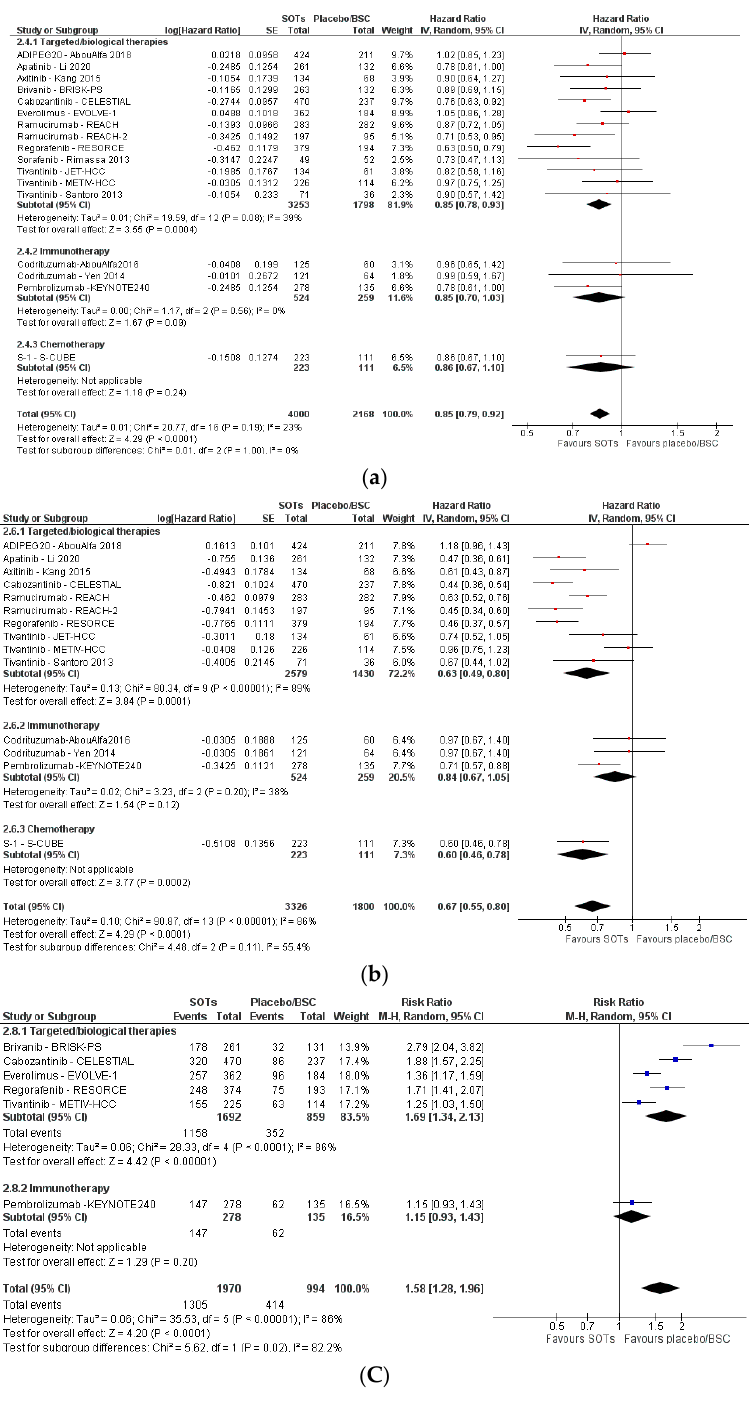
Figure 5. Forest plots for the outcomes ‘overall survival’ ( a ), ‘progression-free survival’ ( b ) and ‘toxicity’ ( c ) for the comparison of SOTs versus placebo/UPSC as second-line therapy or more in patients with advanced HCC.